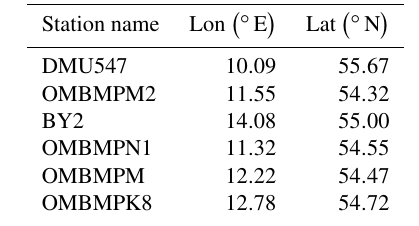
Table 1. List of stations used for validation. The first three stations (DMU547, OMBMPM2, and BY2) are considered in the paper, whereas the last three stations are presented in the Supplement. See also Figs. 3 and 4 for maps containing the station